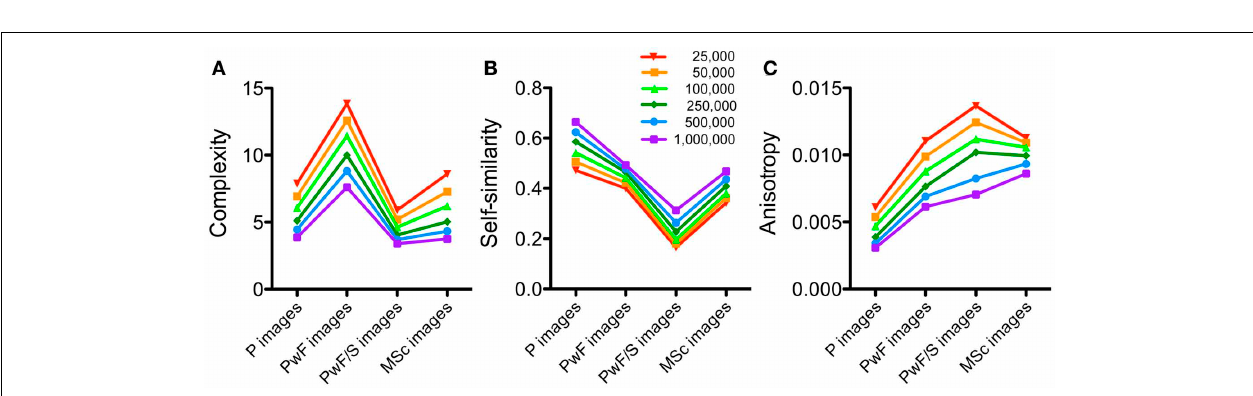
FIGURE 7 | Results for different image resolutions. The National Gallery dataset was analyzed for image complexity (A) , self-similarity (B) , and anisotropy (C) . Image categories are indicated below the x axis. Colors indicate the different image resolutions, expressed in number of pixels, as indicated in (B)